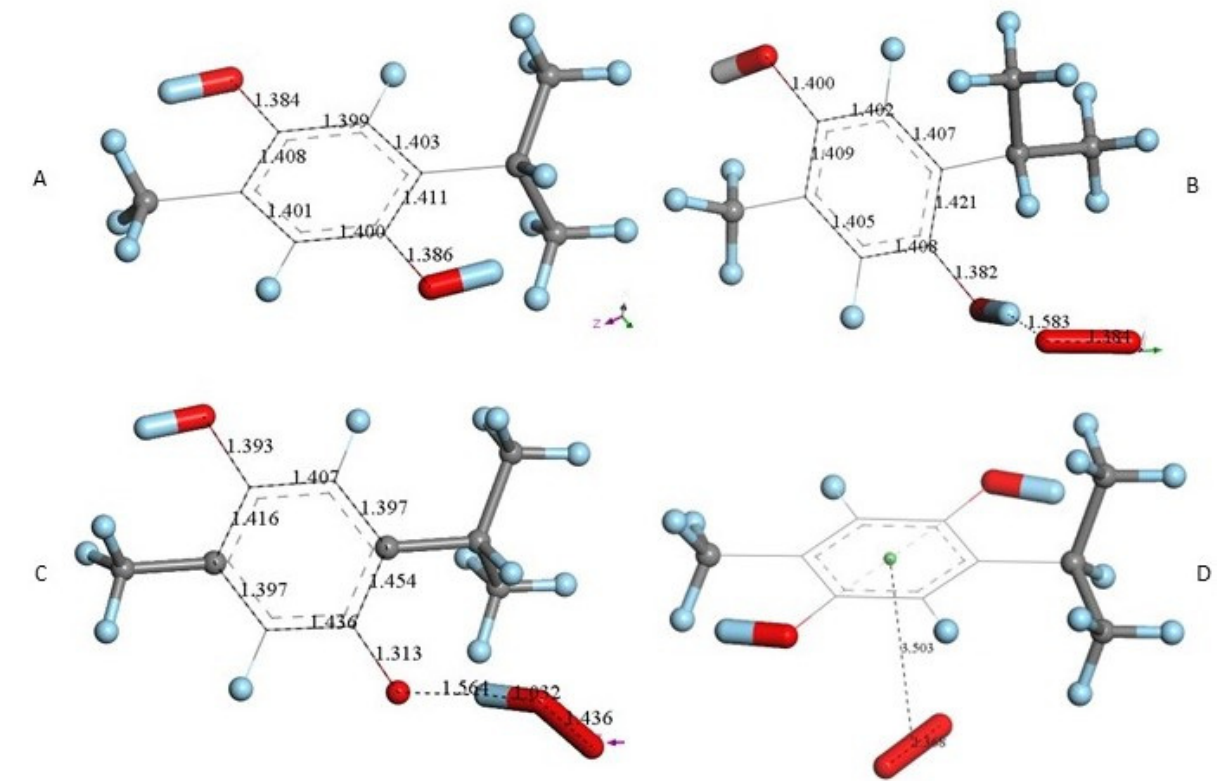
Figure 6. THQ DFT calculations. ( A ) Geometry minimization of thymohydroquinone X-ray co- ordinates. ( B ) Minimization obtained after placing a van der Waals separated superoxide from one H(hydroxyl). ( C ) Minimization obtained after placing a van der Waals separated HO 2 − from thymohydroquinone radical. ( D ) Minimization obtained after placing a π - π van der Waals separated superoxide from THQ, 3.50 Å. Initial superoxide bond length of 1.373 Å had only a slight variation, 1.368 Å. This indicates rejection between both